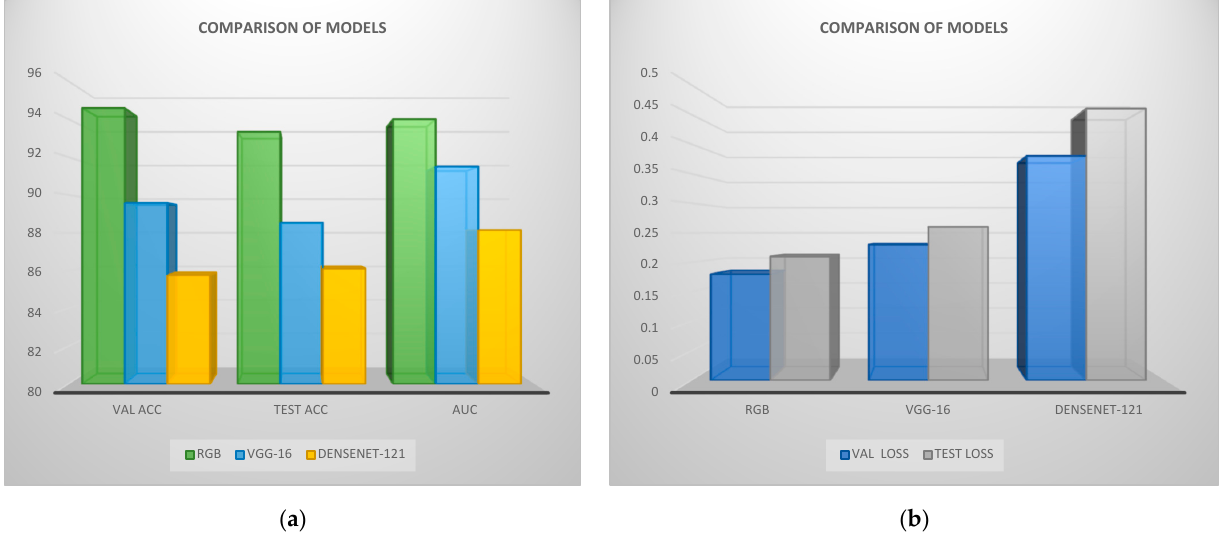
In Figure 13, the comparison of RGB-CNN, VGG-16, and DenseNet-121 is illustrated with respect to the produced validation and testing accuracy, AUC, and validation and testing loss results for each model. It is observed that RGB extracted the best results, for the case where VGG-16 has similar results in validation and testing loss. DenseNet-121 performed adequately.